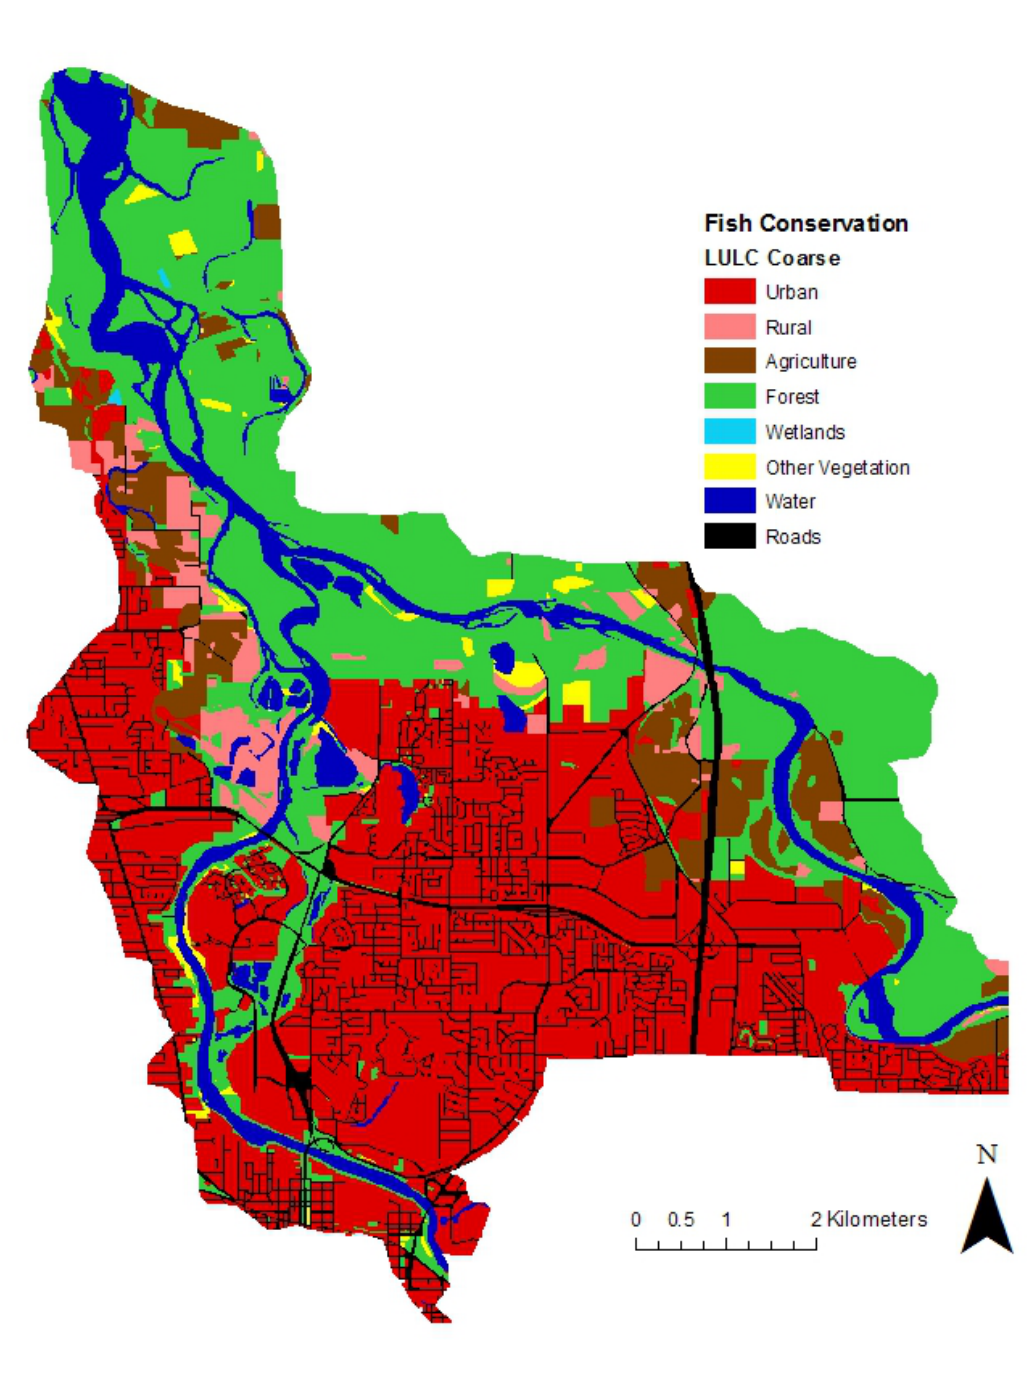
Fig. 9 . Study area after a typical 50-yr run of the fish conservation